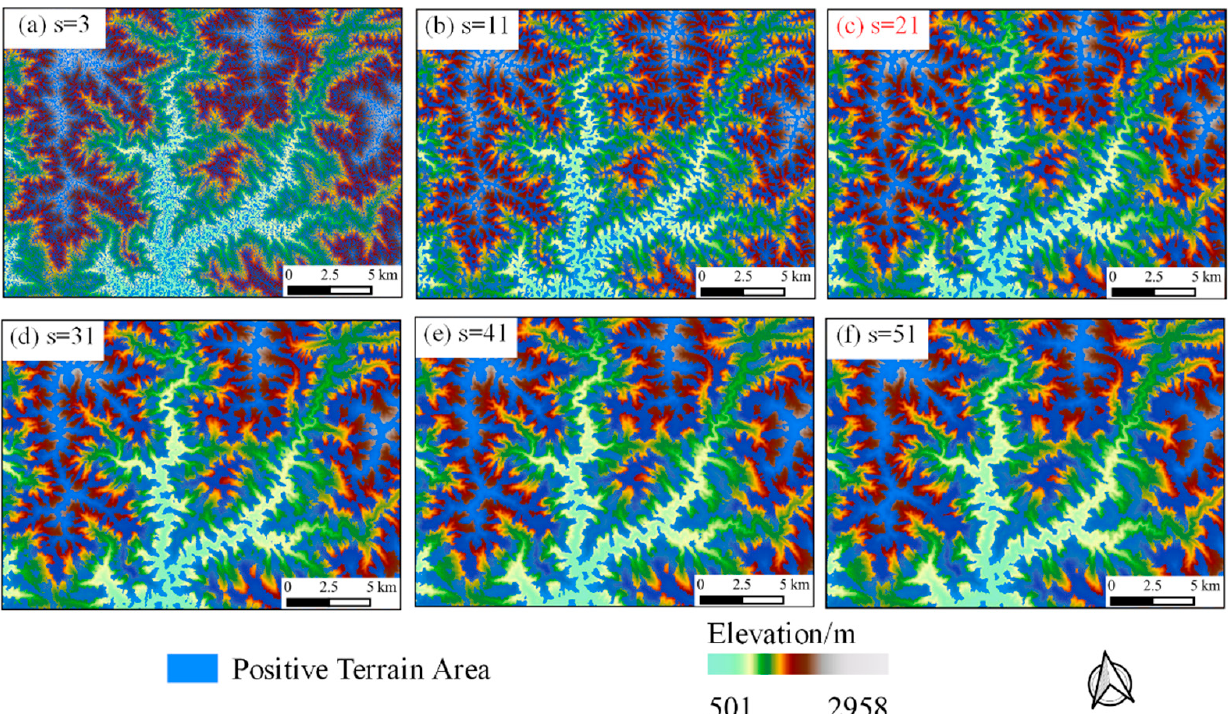
Figure 7. The results of positive terrain extracted with different window sizes of neighborhood analysis in Ningshan County: ( a – f ) the positive terrain distribution of Ningxia County extracted with different window sizes of neighborhood analysis. The positive terrain areas are shown as blue, the upper left corners are the window sizes of these subplots, the analysis window sizes from subplot ( a ) to subplot ( f ) are 3, 11, 21, 31, 41 and 51, respectively. Among them, subplot ( c ) shows positive terrain distribution corresponding to the optimal analysis window size (s = 21) extracted using the proposed